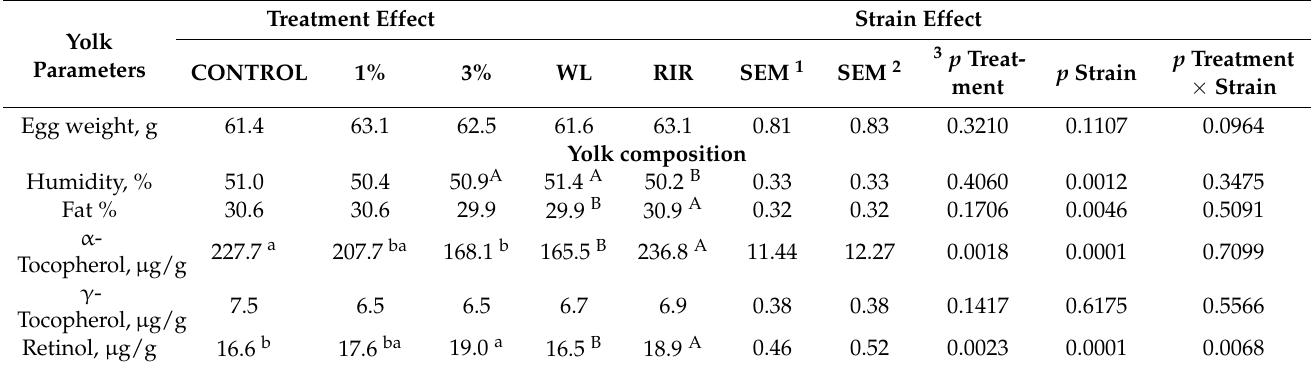
Table 3. Effect of dietary spirulina and strain of laying hens (White Leghorn: WL or Rhode Island Red: RIR) on egg weight and yolk composition.